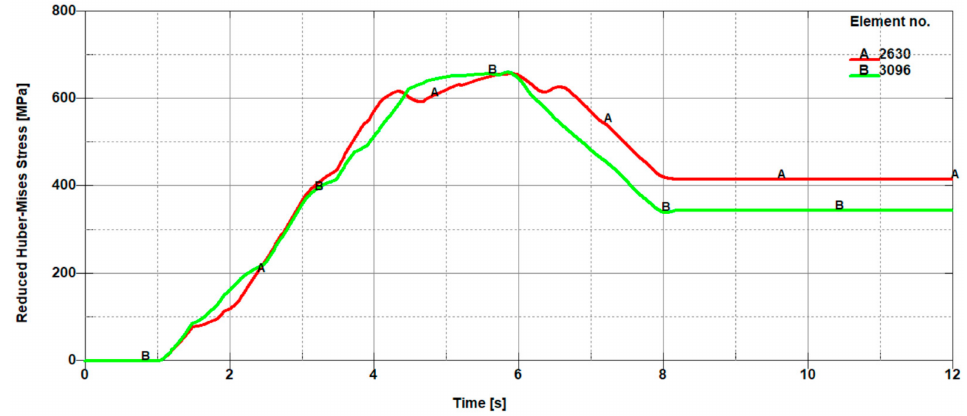
Figure 13. Mean reduced Huber–Mises stresses from the front (A 2630) and from the back (B 3096) of a cutting tool, which correspond to finite element numbers 2630 and 3096, respectively (Figure 11).